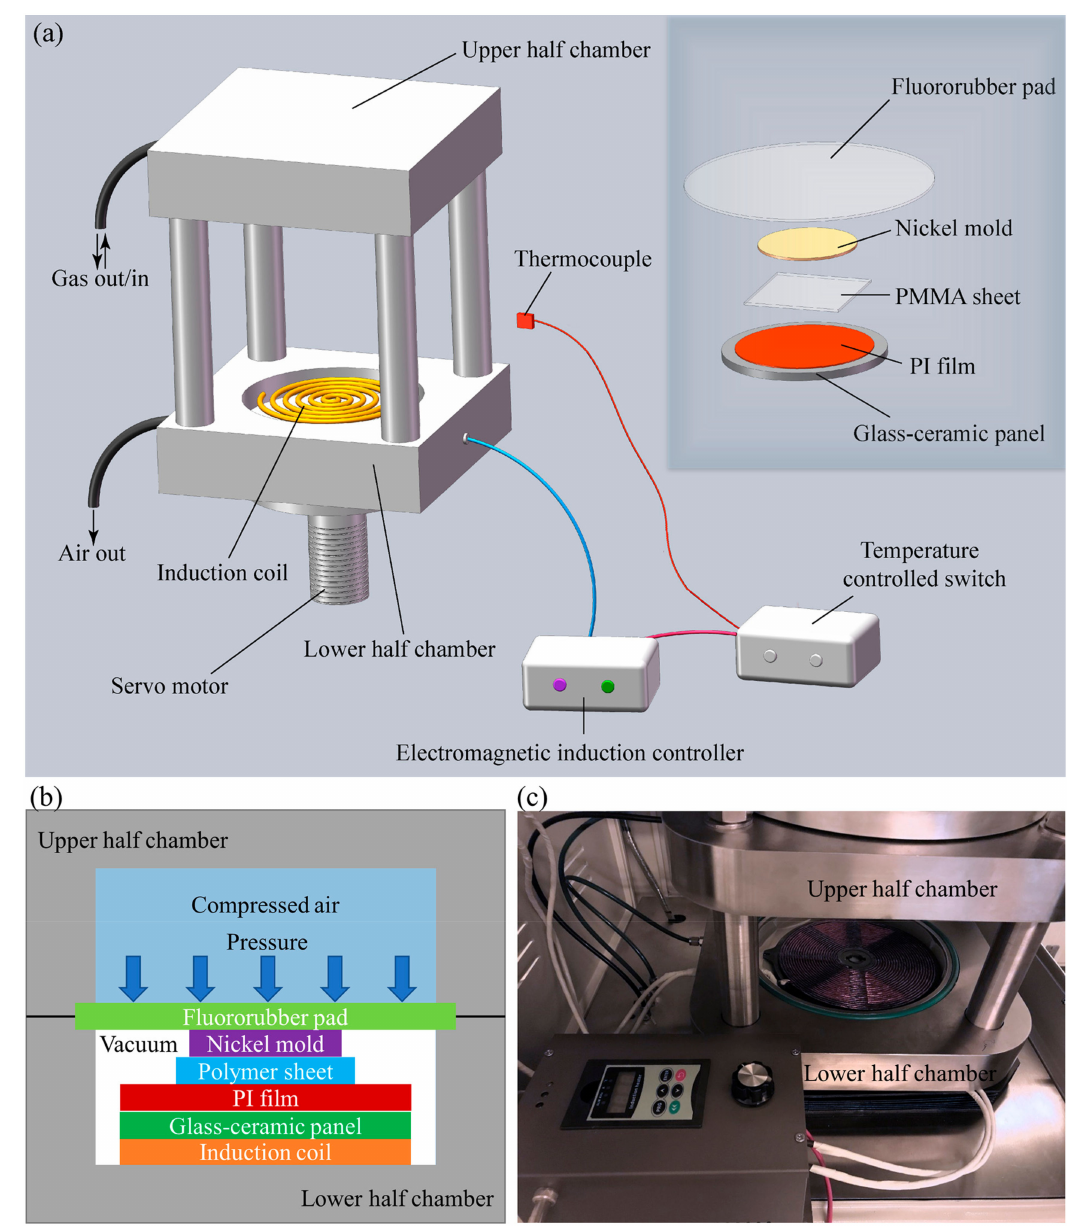
Figure 1. Experimental setup for rapid thermal NIL (T-NIL): ( a ) schematic diagram of the rapid imprint apparatus; ( b ) cross-section view of the chamber and imprint materials stack during the imprint process; and ( c ) photograph of the home-made imprint